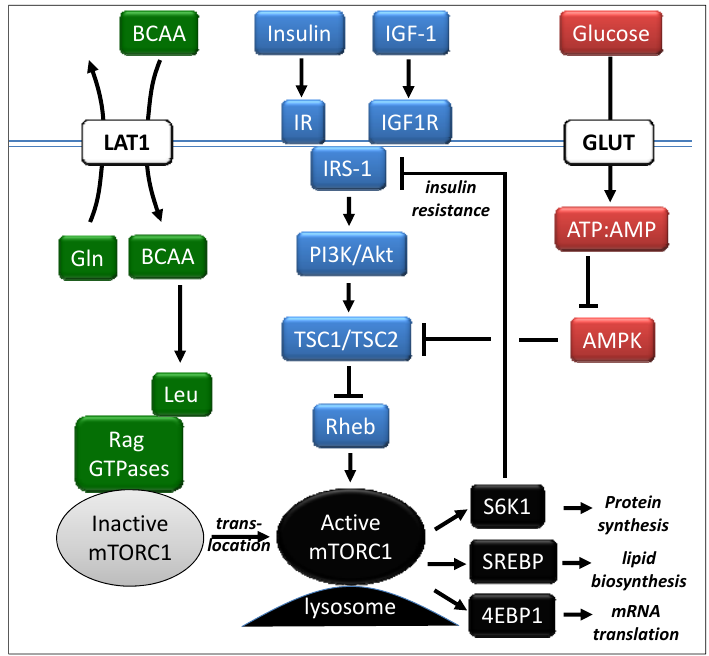
Figure 2. Major cell signaling pathways involving mTORC1. The activity of mTORC1 is modulated by three major pathways (Adapted from Melnik, [47]). Abbreviations: Akt, also known as Protein Kinase B; AMP, adenosine monophosphate; AMPK, adenosine monophosphate kinase; ATP, adenosine triphosphate; 4EBP1, eukaryotic translation initiation factor 4E binding protein 1; GLUT, glucose transport protein; IGF-1, insulin-like growth factor-1; IGF1R, IGF1 receptor; IR, insulin receptor; IRS-1, insulin